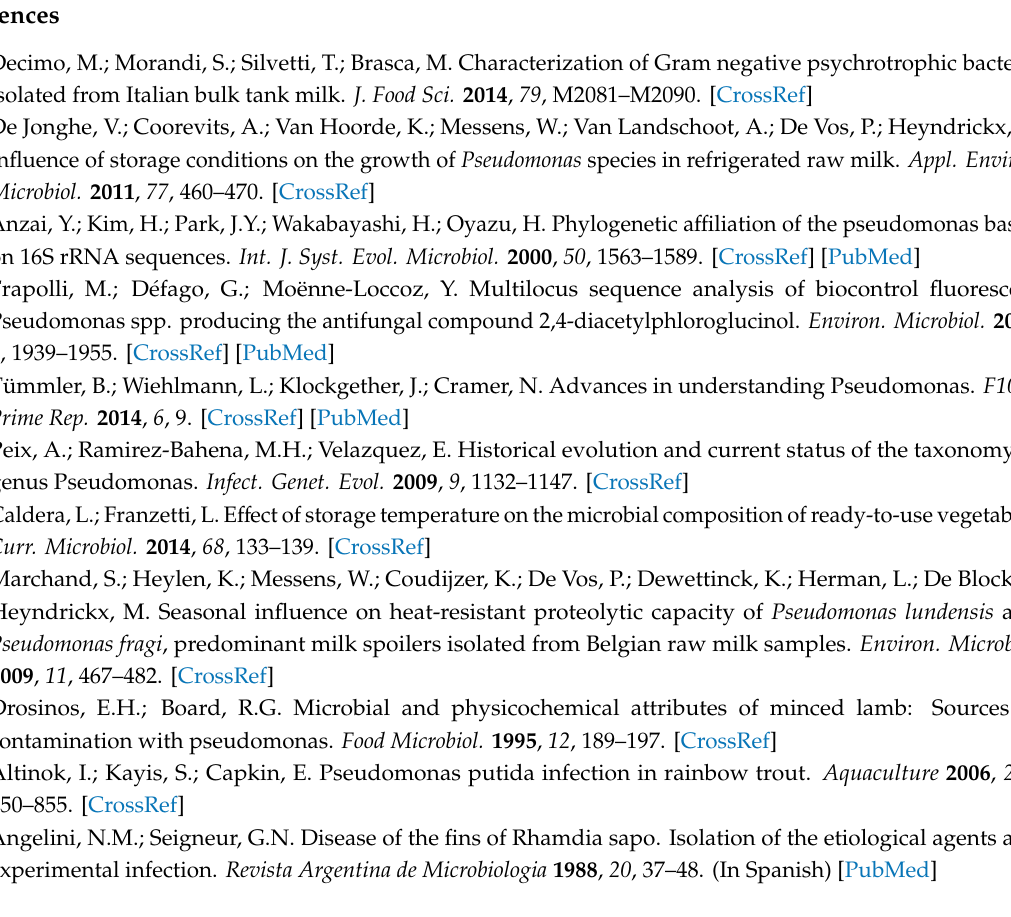
s1, Figure S1: Cladrogram showing the phylogenetic relationships among the 16S rRNA sequences from microorganisms belonging to the genus Pseudomonas . The sequence from this study is highlighted by a red arrow. Bootstrap values are reported at nodes, Table S1: List of 16S rRNA gene sequences used in this